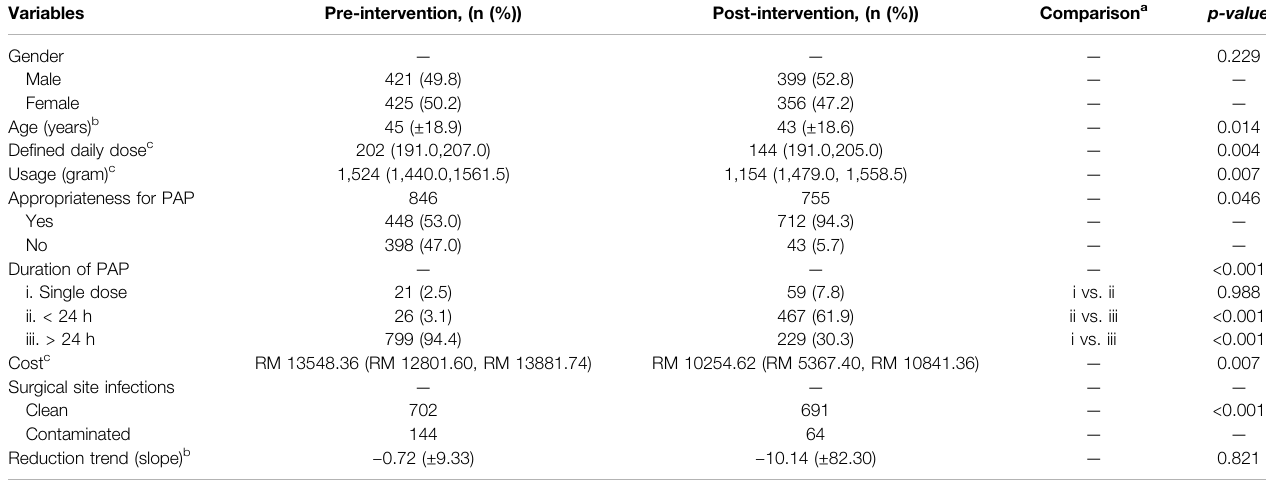
TABLE 2 | Univariate analysis between pre-intervention and post-intervention of various variables used to evaluate the impact of antimicrobial stewardship program.